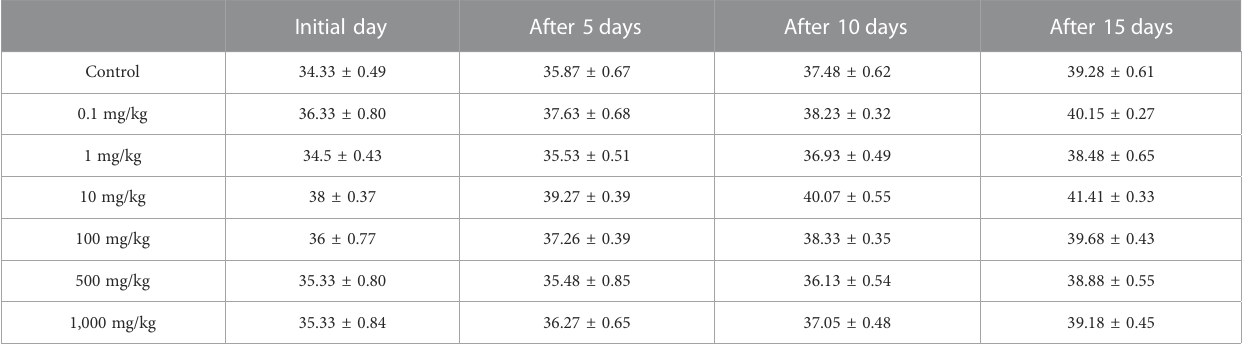
TABLE 7 Body weight of mice during subacute